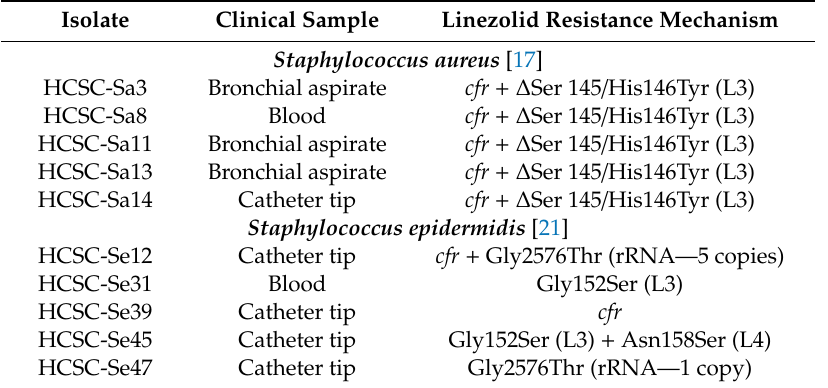
Table 4. Staphylococcal strains included in the study, isolated in an intensive care unit, Madrid, Spain.